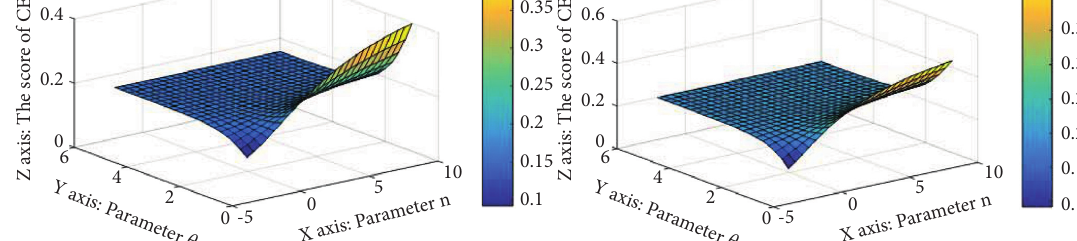
with parameter values 1 ≤ θ ≤ 6, − 2 ≤ n ≤ 10. 1